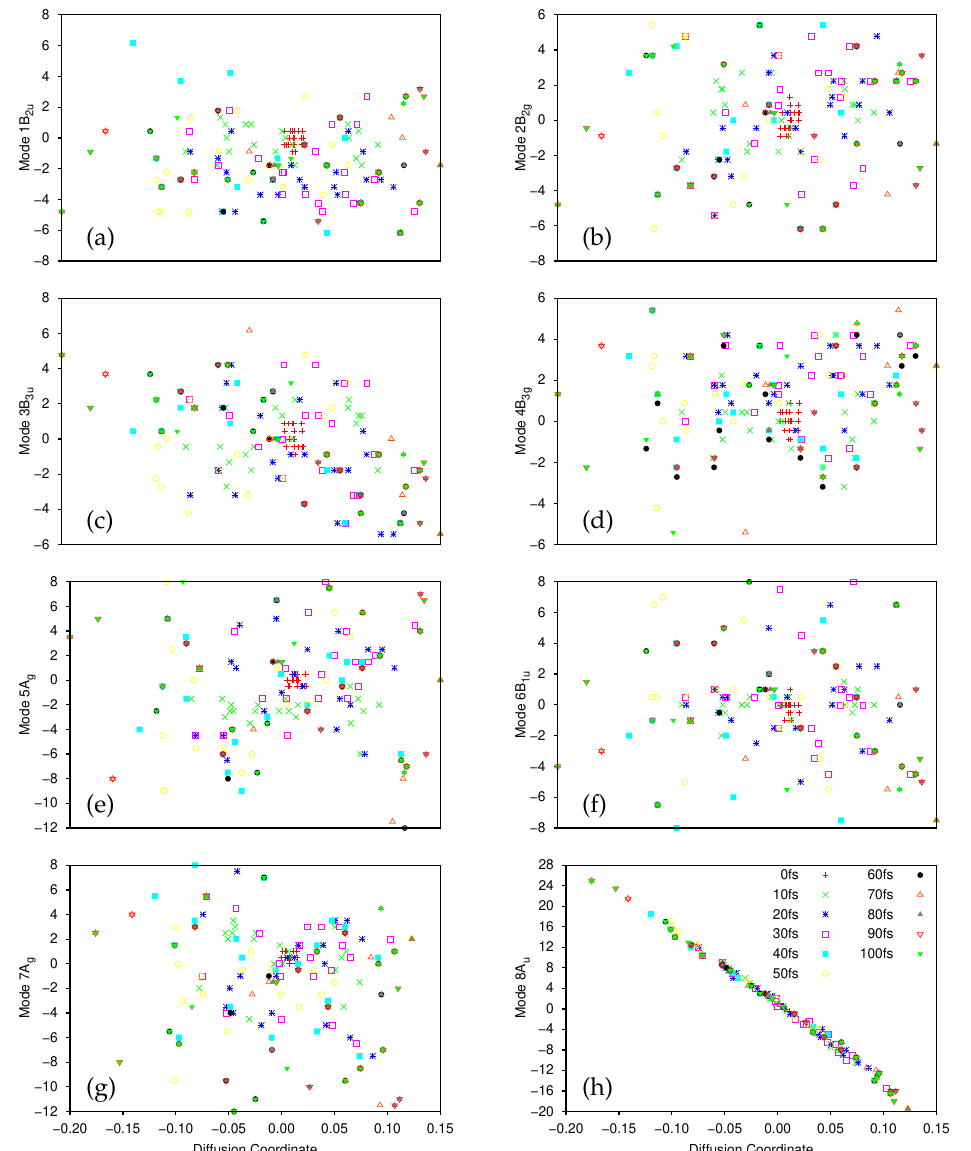
Figure 6. Normal mode coordinates of ethene, sampled on the first, diabatic electronic excited state, plotted as functions of the diffusion coordinate: ( a ) Mode 1B 2 u ; ( b ) Mode 2B 2 g ; ( c ) Mode 3B 3 u ; ( d ) Mode 4B 3 g ; ( e ) Mode 5A g ; ( f ) Mode 6B 1 u ; ( g ) Mode 7A g ; ( h ) Mode 8A u . In all cases data points are coloured according to the sample time; 20 gridpoints were sampled every 10fs during the dynamics. Key within plot ( h ) applies to all other